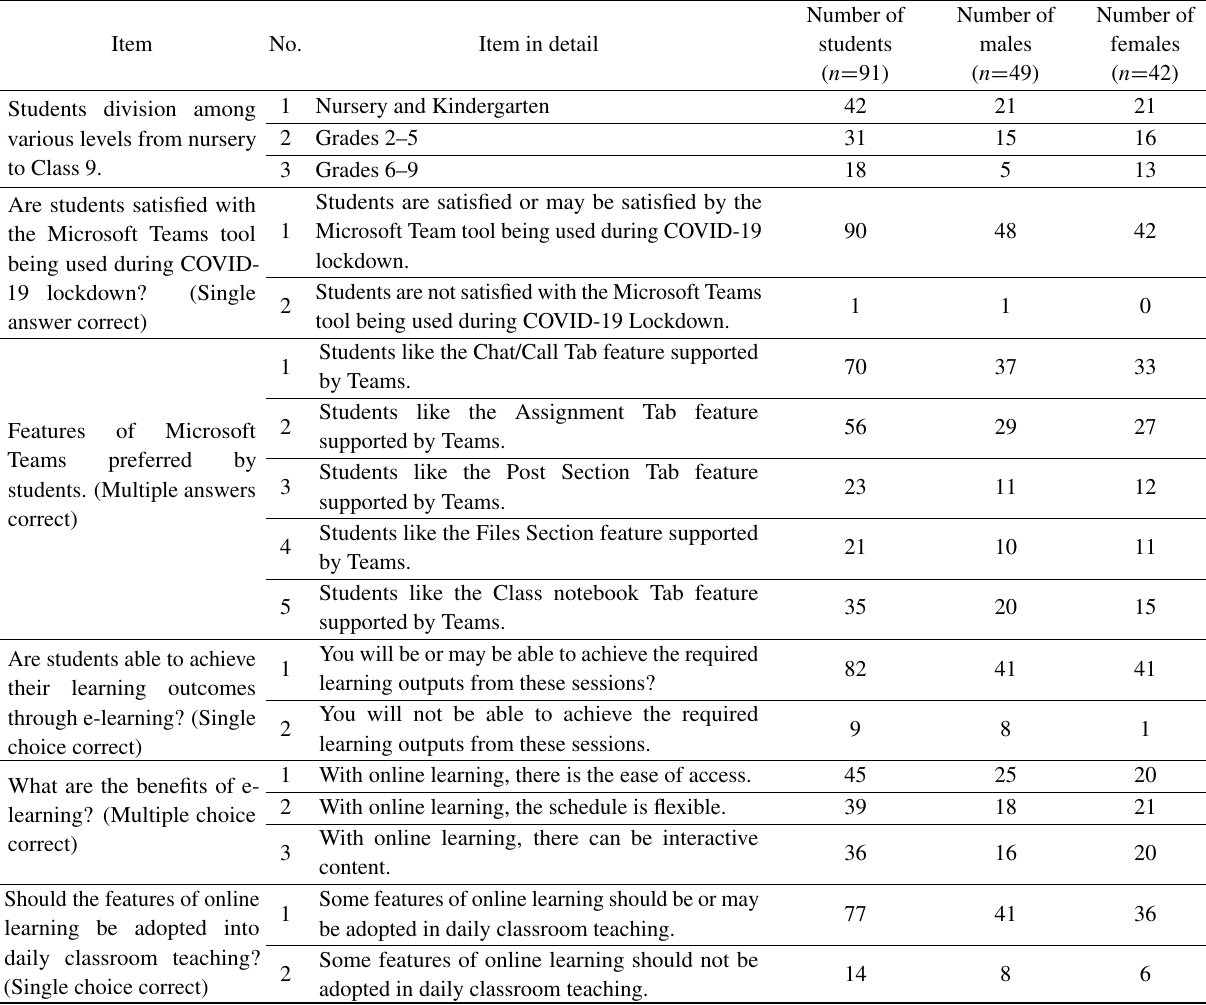
Table 4 Students’ response to survey conducted regarding e-learning practices adopted by teaching faculty of Manav Rachna International School,